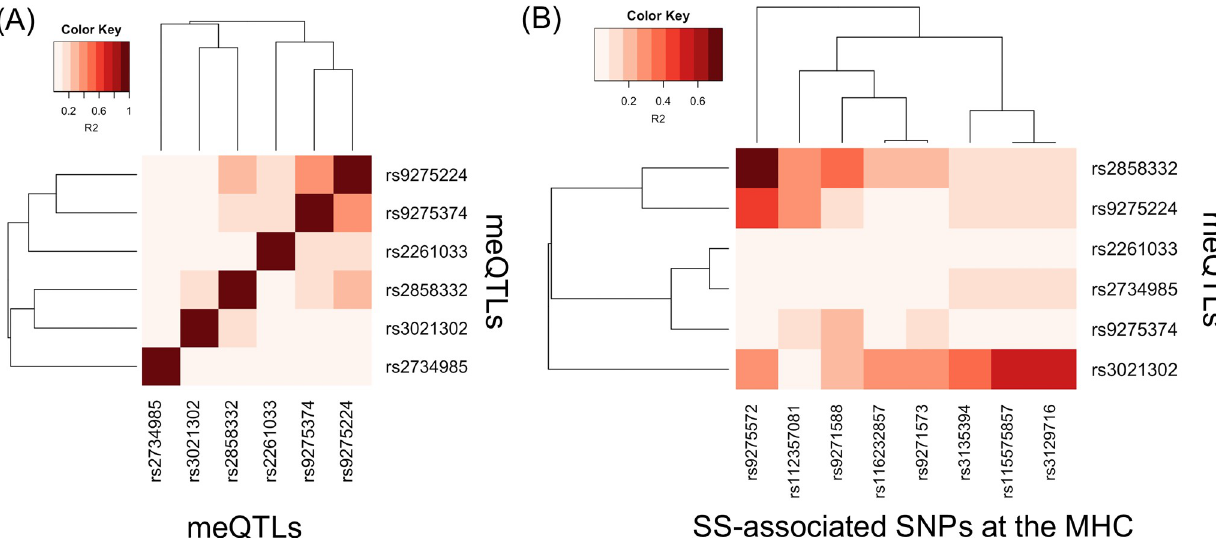
Fig 4. LD heatmap for MHC meQTLs supporting the causal mediation model. Heatmap of the LD measure of R 2 statistics, based on European populations from the 1000 Genomes Project [55]. (A) LD among meQTLs and (B) LD between meQTLs and established SS-associated SNPs at the MHC, for Europeans [7, 8].